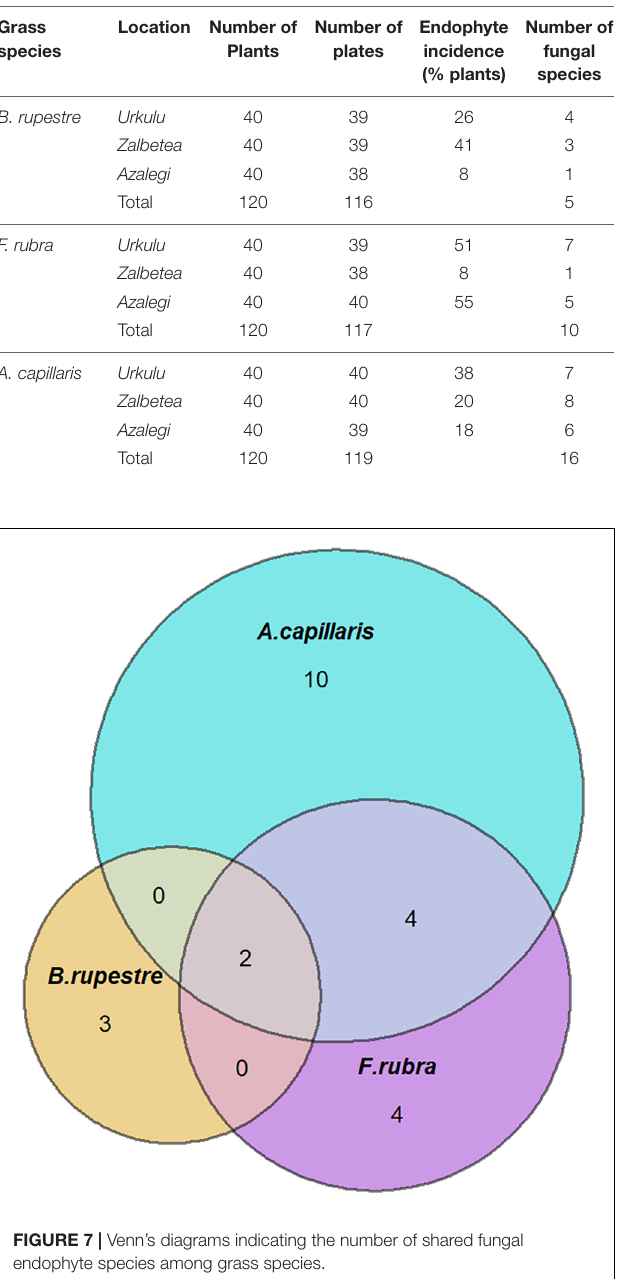
TABLE 4 | Number of plants collected, number of final plates (taking into account the contaminations), fungal endophyte incidence (% plants), and number of fungal taxa per location for each grass species from high-diversity grasslands in aboveground tissues.